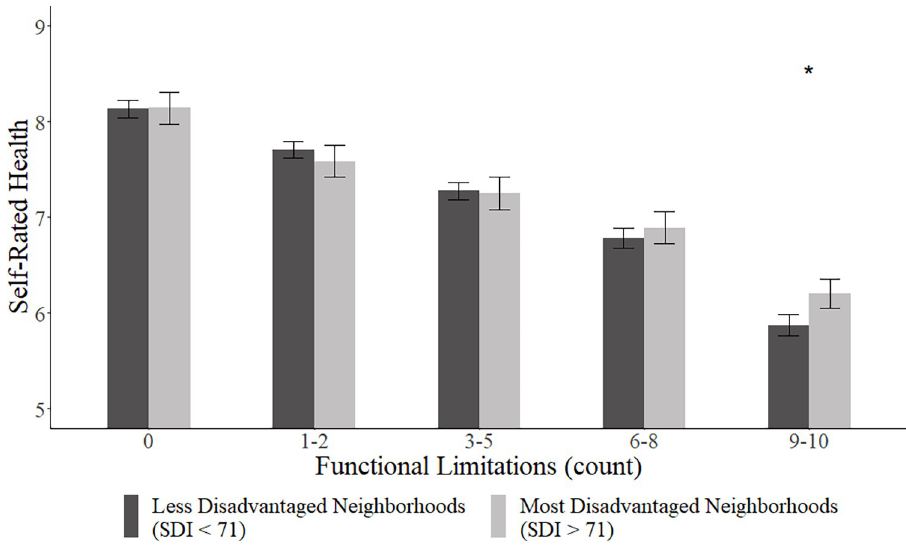
Fig 1. Association between functional limitations and self-rated health by neighborhood disadvantage. Note: Error Bars = 95% confidence interval; Dark grey bar = Disadvantaged neighborhoods (SDI > 71); Light grey bar = Advantaged neighborhoods (SDI <